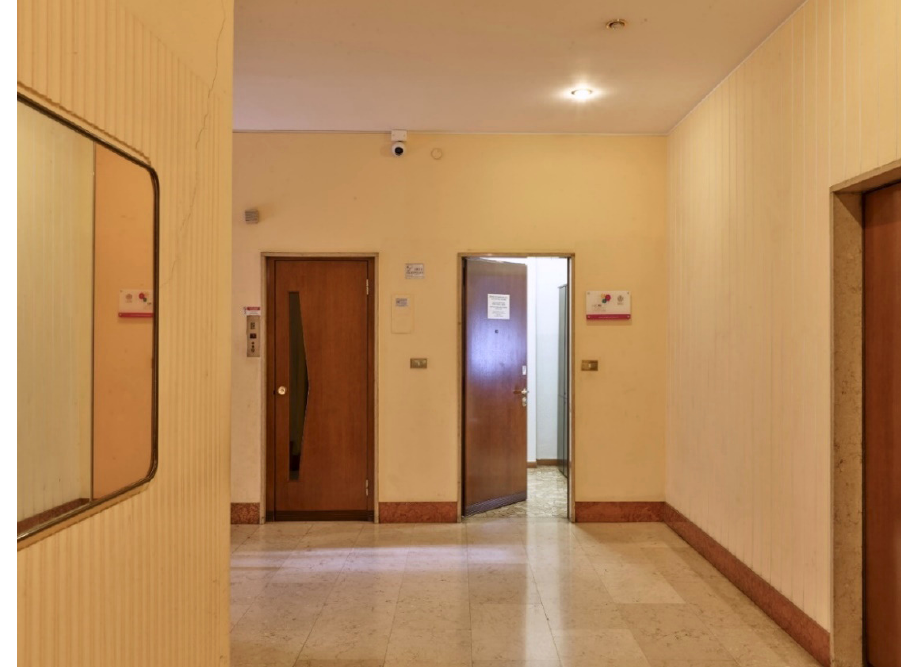
Figure 7. The residential building of WeMi Loreto. Source: Courtesy of Giovanni